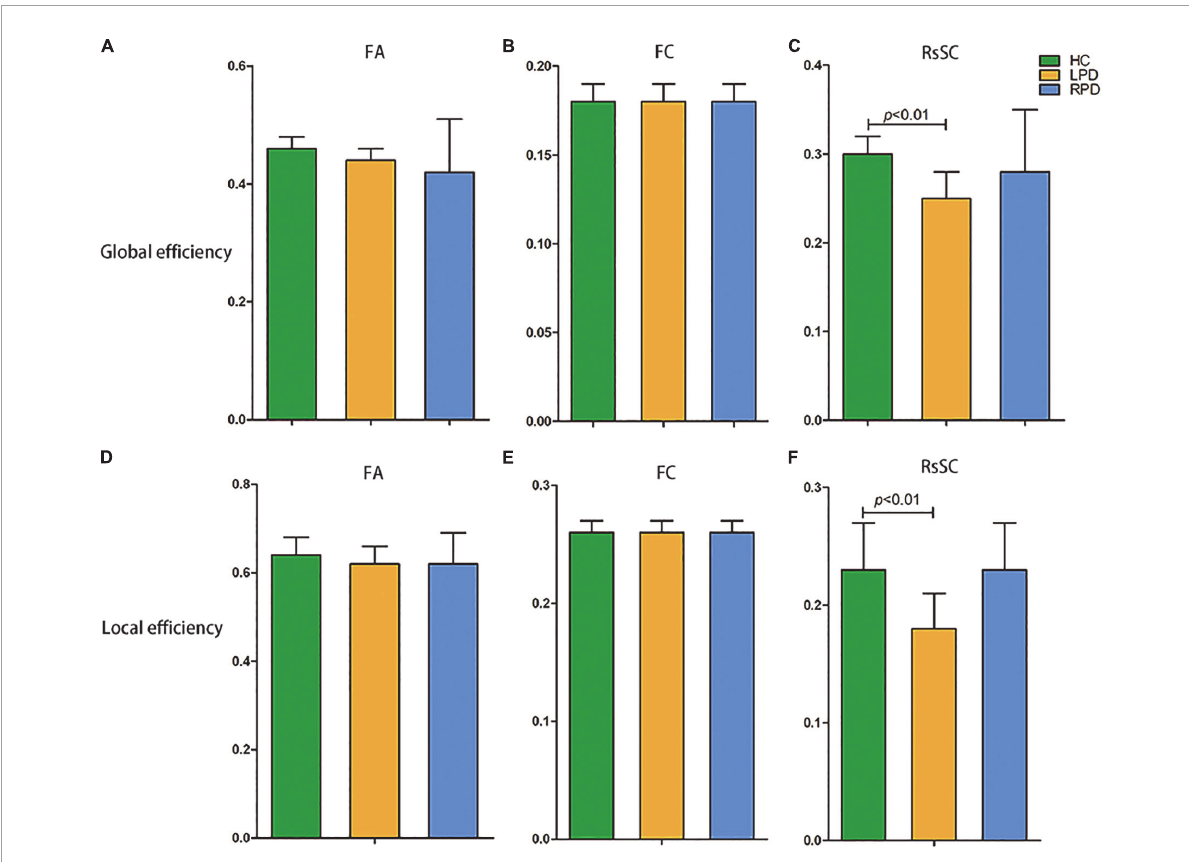
FIGURE1 Decreased global efficiency (C) and local efficiency (F) were revealed in left-onset PD (LPD) patients compared with healthy controls (HCs) when the resting-state-informed structural connectome (rsSC) network was used, but no difference in global or local efficiency was revealed between LPD and right-onset PD (RPD) or between RPD and HCs. In the comparison fMRI (FC) and DTI (FA) network metrics, no significant difference was found in global or local efficiency among the LPD, RPD and HC groups (A,B,D,E) . FA, fractional anisotropy; FC, functional